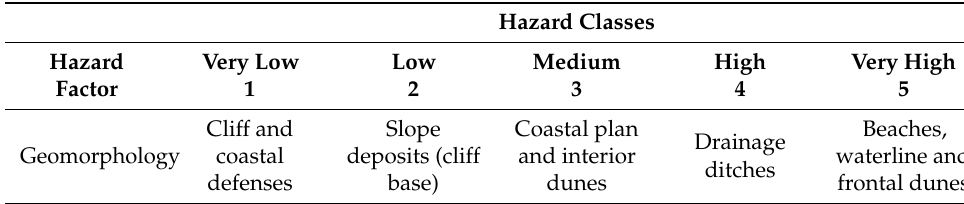
Table 5. Hazard classification concerning the geomorphology hazard factor.